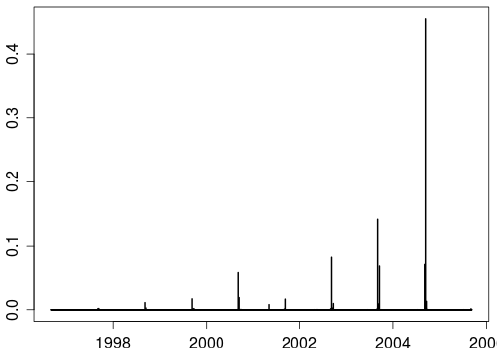
Figure 6. Vector of weights (sorted chronologically) obtained for the prediction of a day during Spring. Figure 7 is also of interest to understand how the prediction works. There, the plot on the left contains all the days of the dataset against which the similarity was computed with respect to the curve in blue. A transparency scale which makes visible only those curves with a relatively high similarity index. The plot on the right contains the futures of the past days on the left. These are also plot on the transparent scale with the curve in orange which is the prediction given by the weighted average.